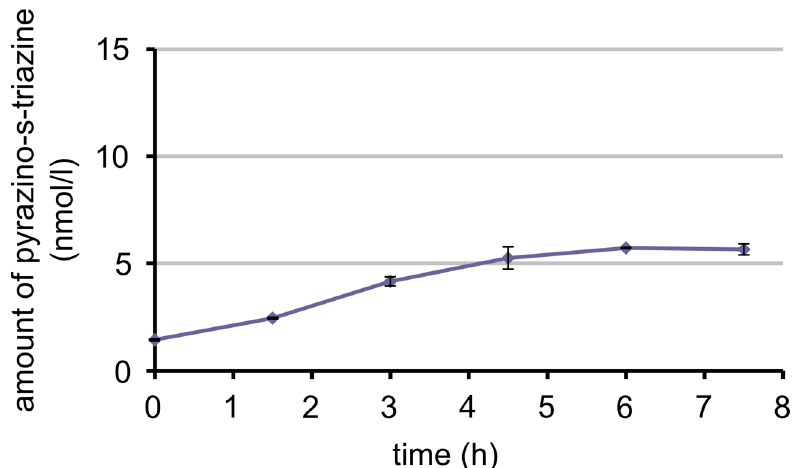
Figure 10. Amount of pyrazino-s-triazine (MeFox, oxidation product of 5-CH 3 –H 4 folate) in plasma (heparin plasma) over time after ingestion of couscous (rich in MeFox, low in folate).